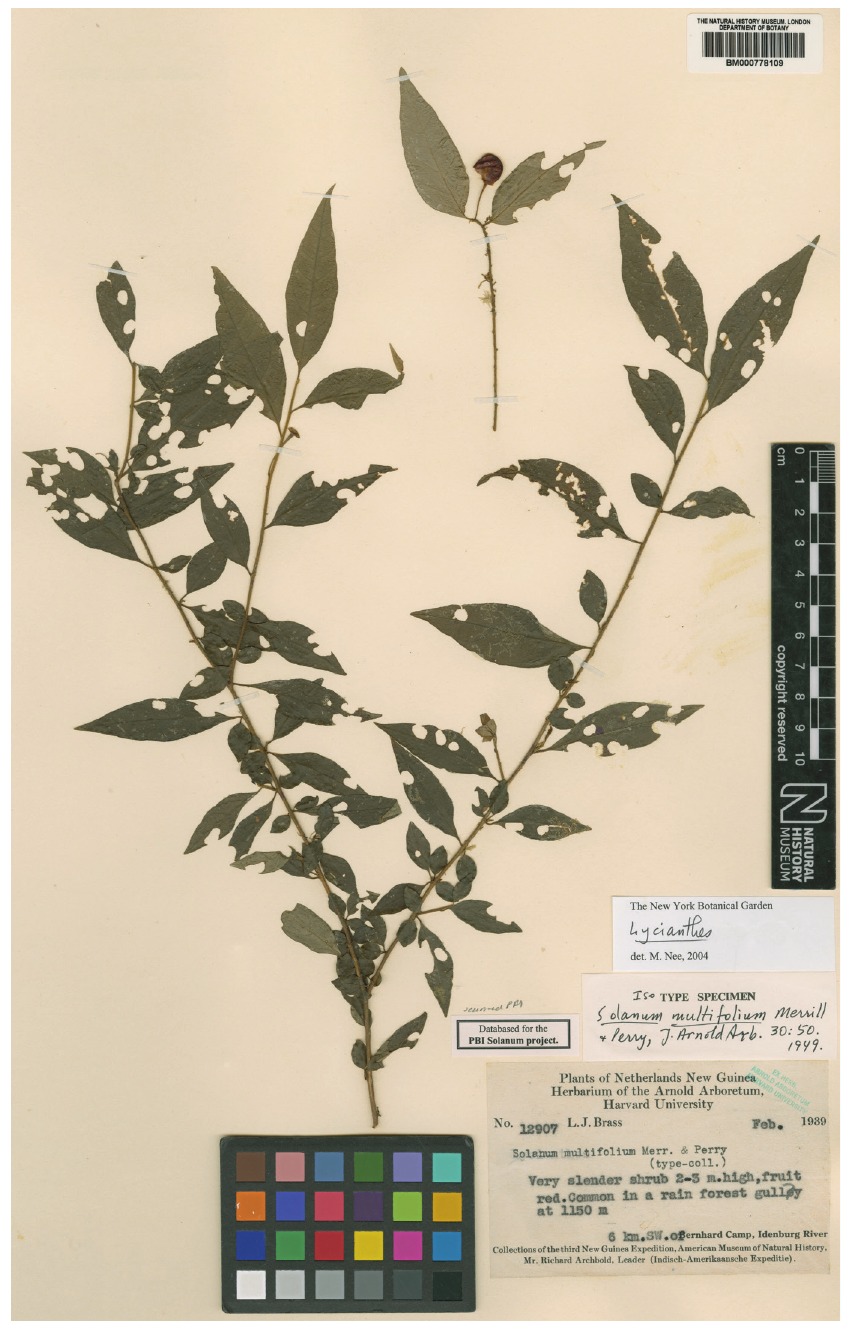
Figure 35. Lycianthes multifolia herbarium specimen. Indonesia. Papua: Brass 12907 (isotype of S. multifolium , BM000778109). Courtesy of the Trustees of the Natural History Museum, London, reproduced with